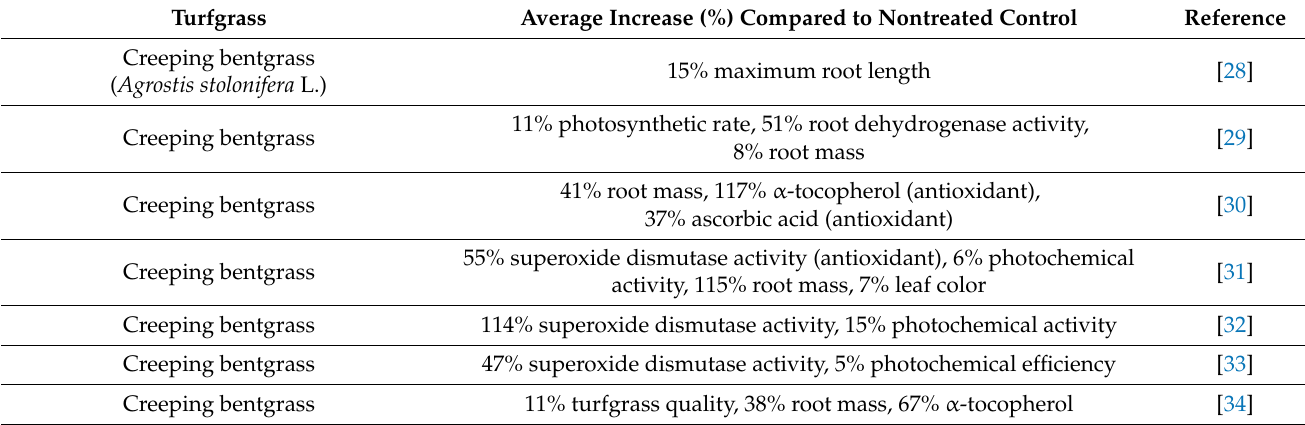
Table 1. Benefits of humic substances on turfgrass plant and soil health